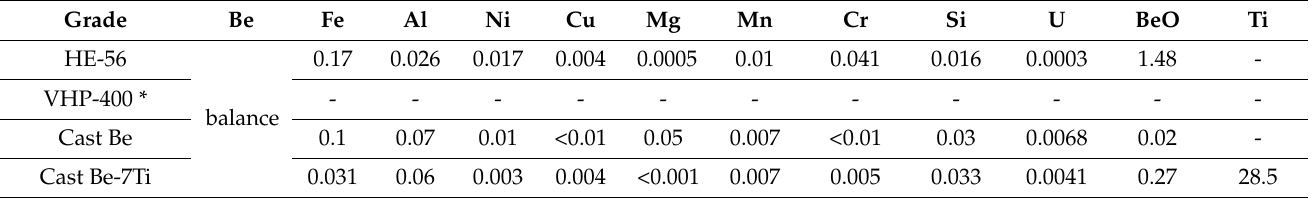
Table 1. Chemical composition of beryllium-based materials in wt.%.